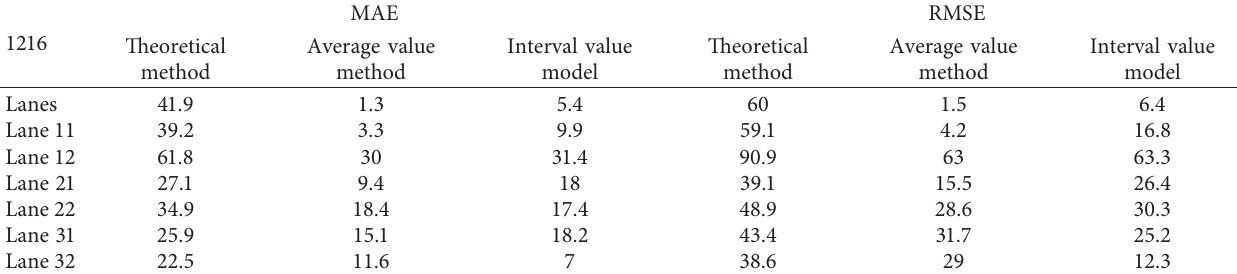
Table 6: Data fitting accuracy by MAE and RMSE on December 16, 2015.